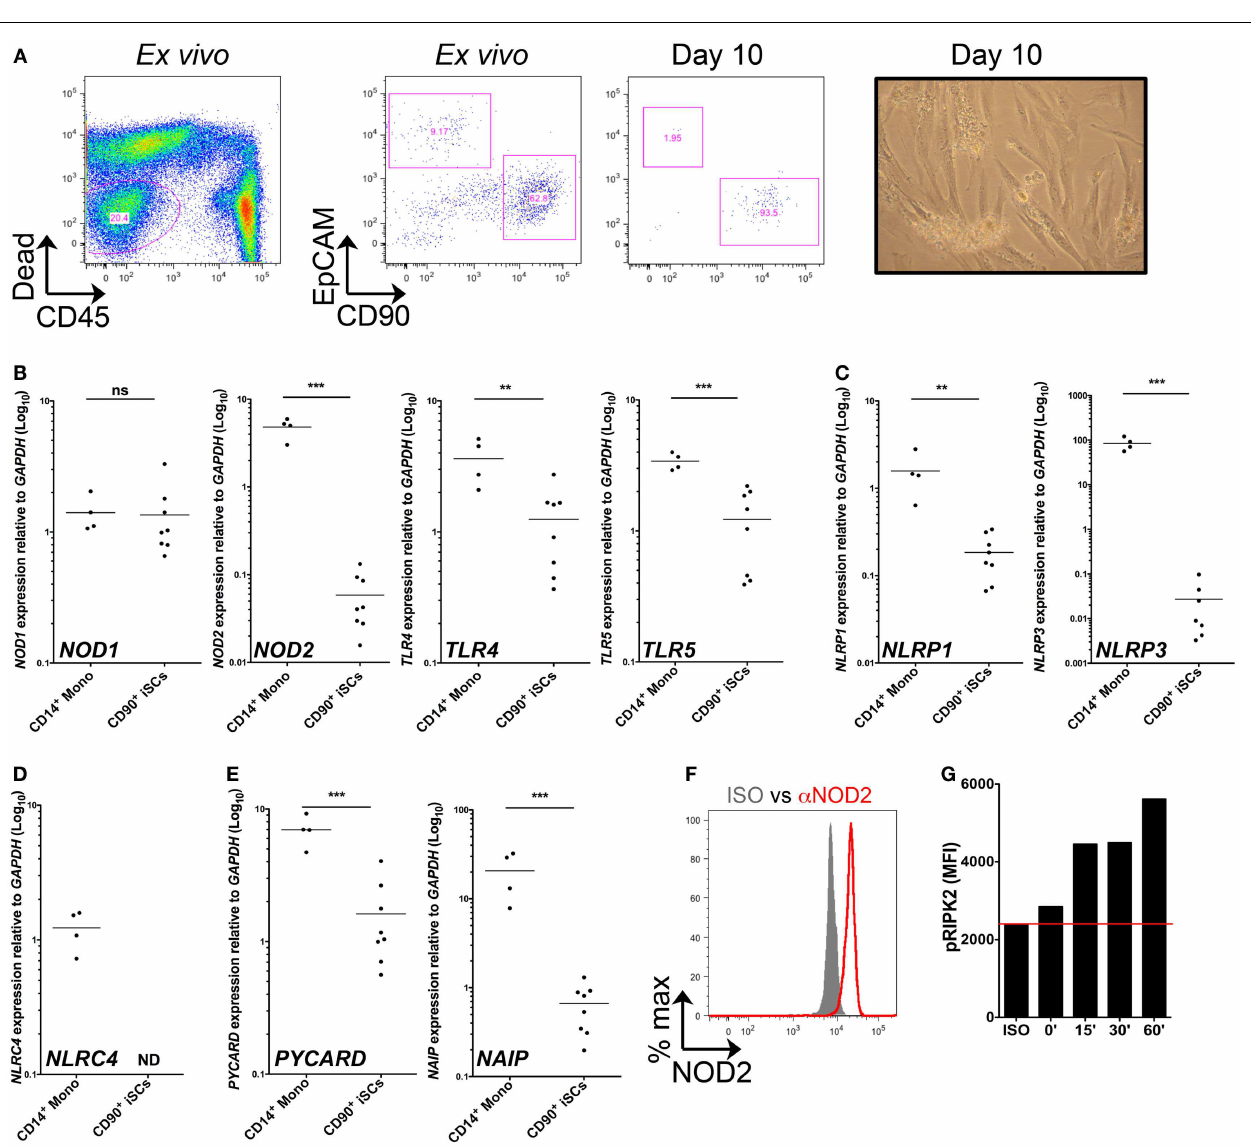
FIGURE 1 | CD90 + colonic stromal cells express diverse PRRs and functional NOD2 . (A) Shows representative flow cytometric staining of collagenase-digested colonic tissue ex vivo and cultured stromal cells after 10days in culture, revealing iSCs as viable, CD45 − EpCAM − CD90 + cells; and a representative image of day 10 cultured stromal cells obtained by light microscopy. (B–E) Show quantification of the expression of the indicted genes in monocytes and cultured iSCs by qRT-PCR, expressed as arbitrary units (AU) relative to GAPDH . (F) Shows quantification of NOD2 expression